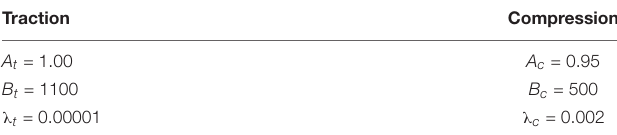
TABLE 2 | Damage parameters of